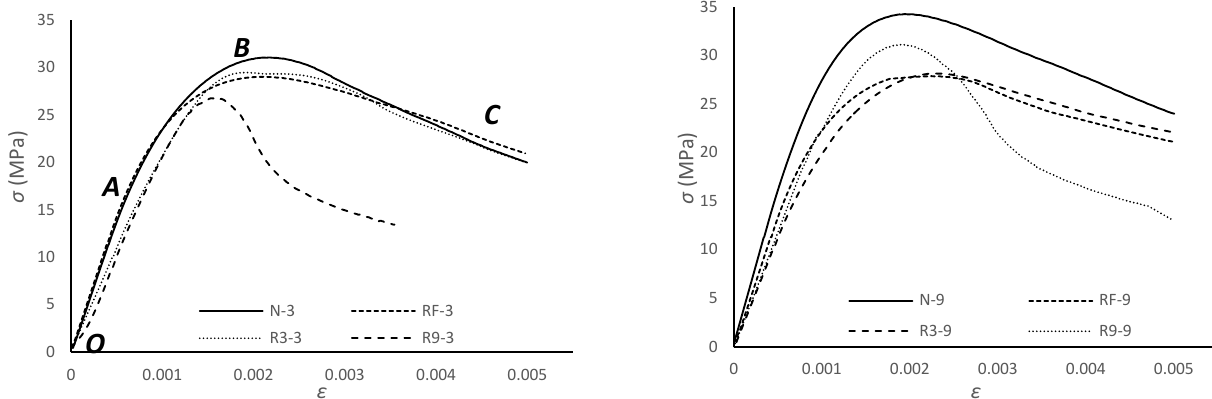
Figure 9. Stress–strain behavior of the tested concretes: 3 kg/m 3 ( left ); 9 kg/m 3 ( right ). For all combinations, the concrete cylinders show a similar pattern to the stress–strain curve [21]. The general pattern observed can be divided into four stages: the elastic stage (O-A), the elastic–plastic stage (A-B), the yield stage (B-C), and the fracture stage, as seen in Figure 9 (left).